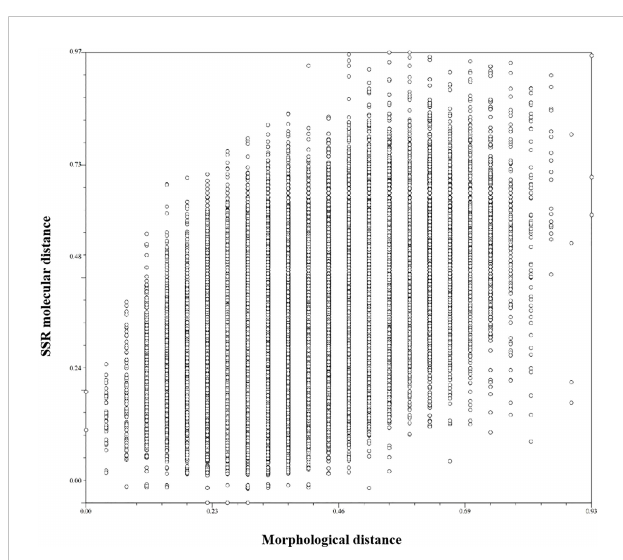
FIGURE 6 Comparison of morphological distance and molecular distance of 423 non-heading Chinese cabbage varieties. The abscissa is morphological distance, and the ordinate is molecular distance. The similarity coef fi cient is